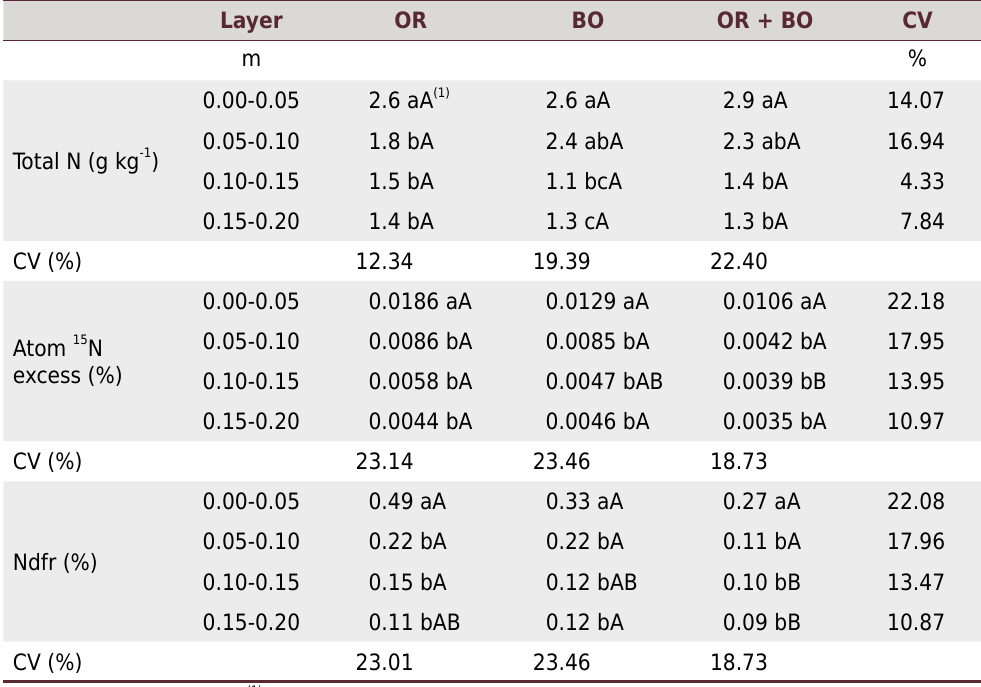
Table 4. Total N, atom 15 N excess, and N derived from residue (Ndfr) in different layers of soil treated with cover crop residues and cultivated with onion [Treatments: oilseed radish (OR), black oats (BO), and oilseed radish + black oats (OR + BO)] Layer OR m %